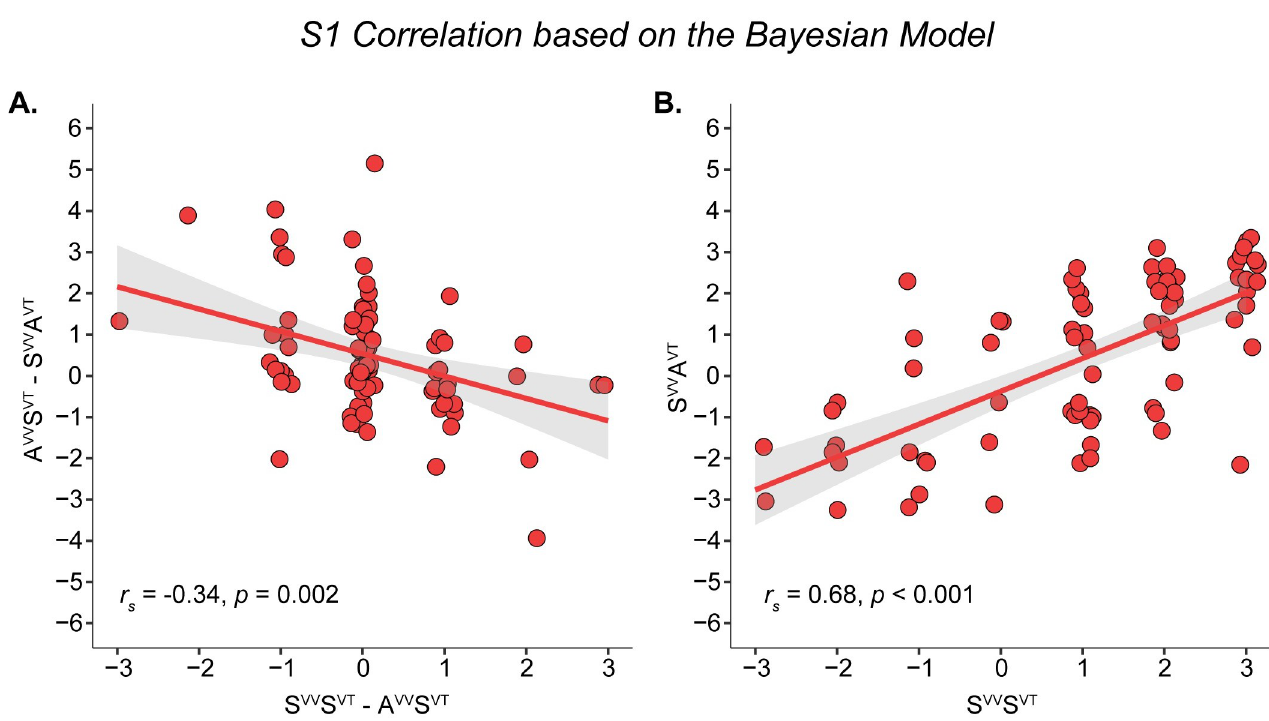
Fig 6. Correlational analyses in support of the proposed Bayesian model. ( A ) Correlation analysis of the difference in questionnaire statement S1 for A VV S VT minus S VV A VT and the corresponding S1 difference S VV S VT minus A VV S VT (N = 80). A linear regression plot is shown for illustrative purposes. This plot shows that, as expected and in agreement with our theoretical model, the greater the visuo–vestibular asynchrony hinders the illusion compared to the fully synchronous condition (x–axis: S VV S VT –A VV S VT ), the weaker the relative dominance of the visuo–tactile information over the visuo–vestibular information (y– axis: A VV S VT –S VV A VT ). ( B ) Positive correlation between S VV A VT and S VV S VT , which further supports the proposed Bayesian model by confirming that the significant correlation shown in A is not driven by condition A VV S VT that is used to calculate both difference scores. The Spearman correlation was r s = 0.68, 95% CI: 0.52–0.8, p < 0.001.